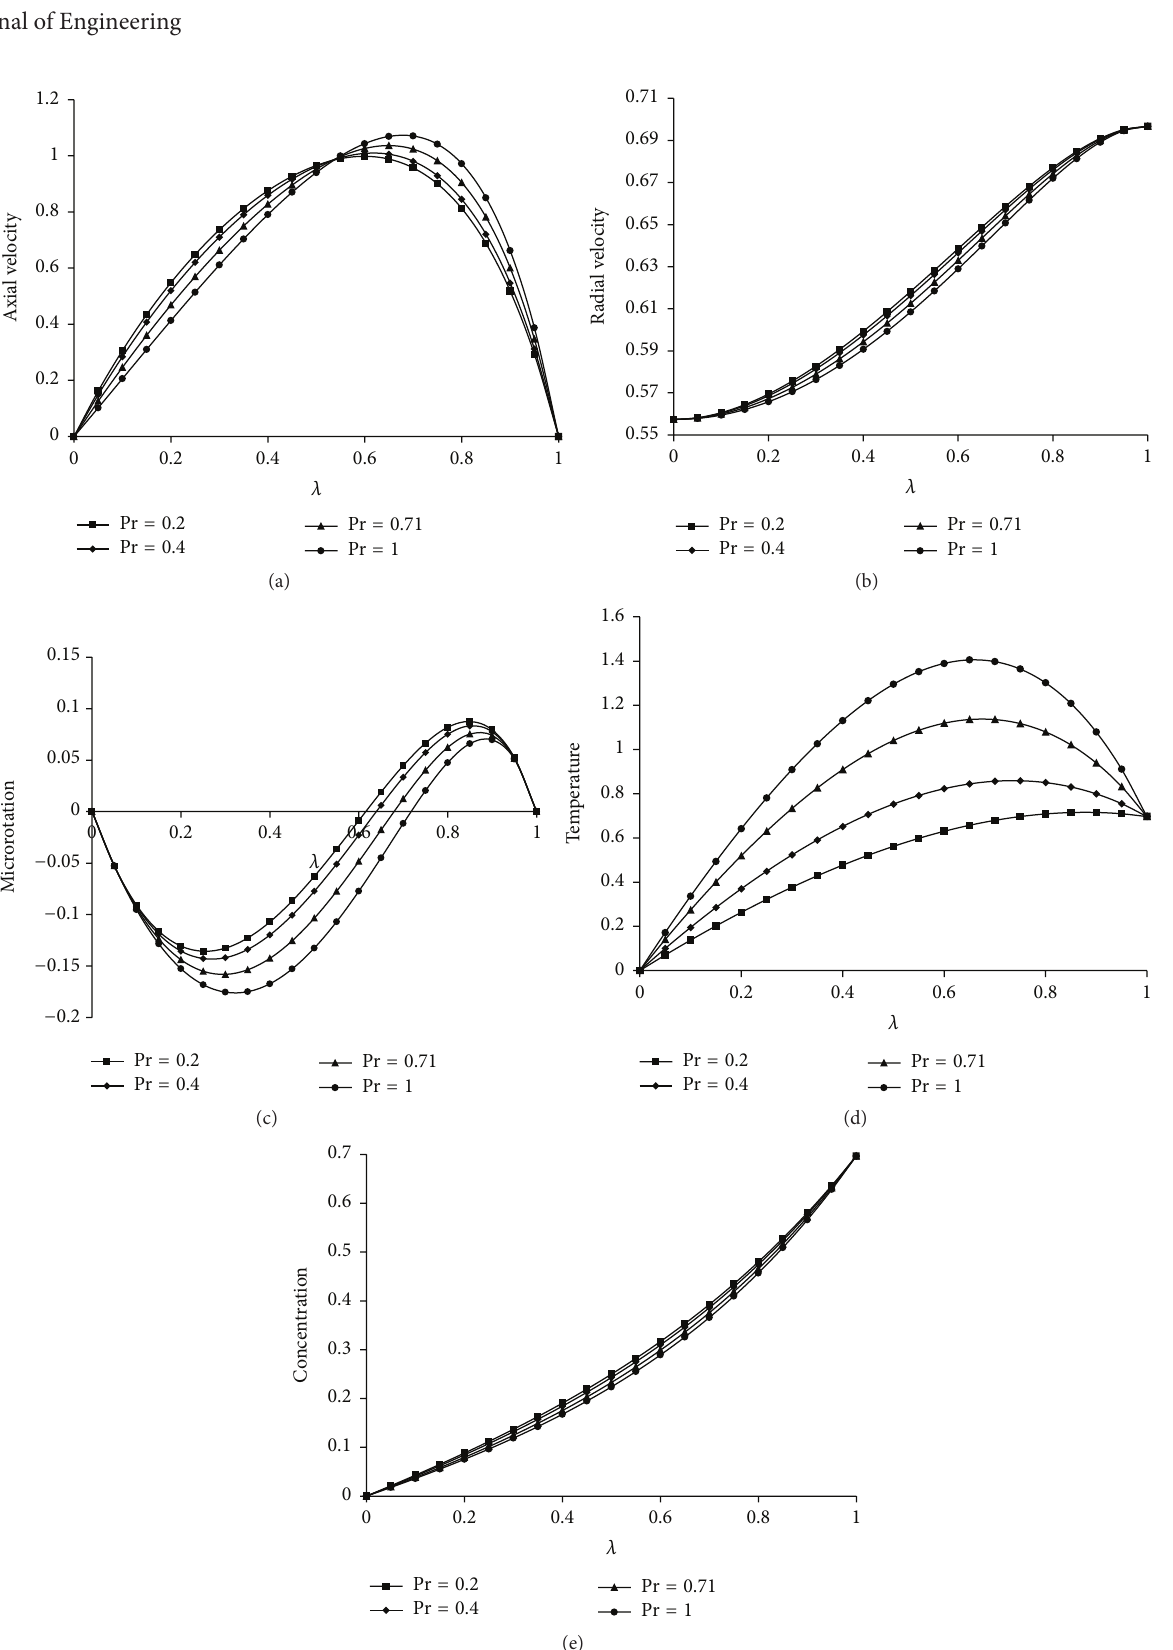
Figure 6: Effect of Pr on (a) axial velocity, (b) radial velocity, (c) microrotation, (d) temperature, and (e) concentration for 𝐷 −1 = 2 , Du = 0.2, Gr = 4, Re = 2, Sr = 0.2, Ha = 2, Sc = 0.22, 𝑎 = 0.2 , 𝜓 = 0.8 , 𝑅 = 2 , 𝐽 1 = 0.2 , 𝑠 1 = 2 , 𝑠 2 = 1 , Gm = 4, Kr = 2, and Ec =